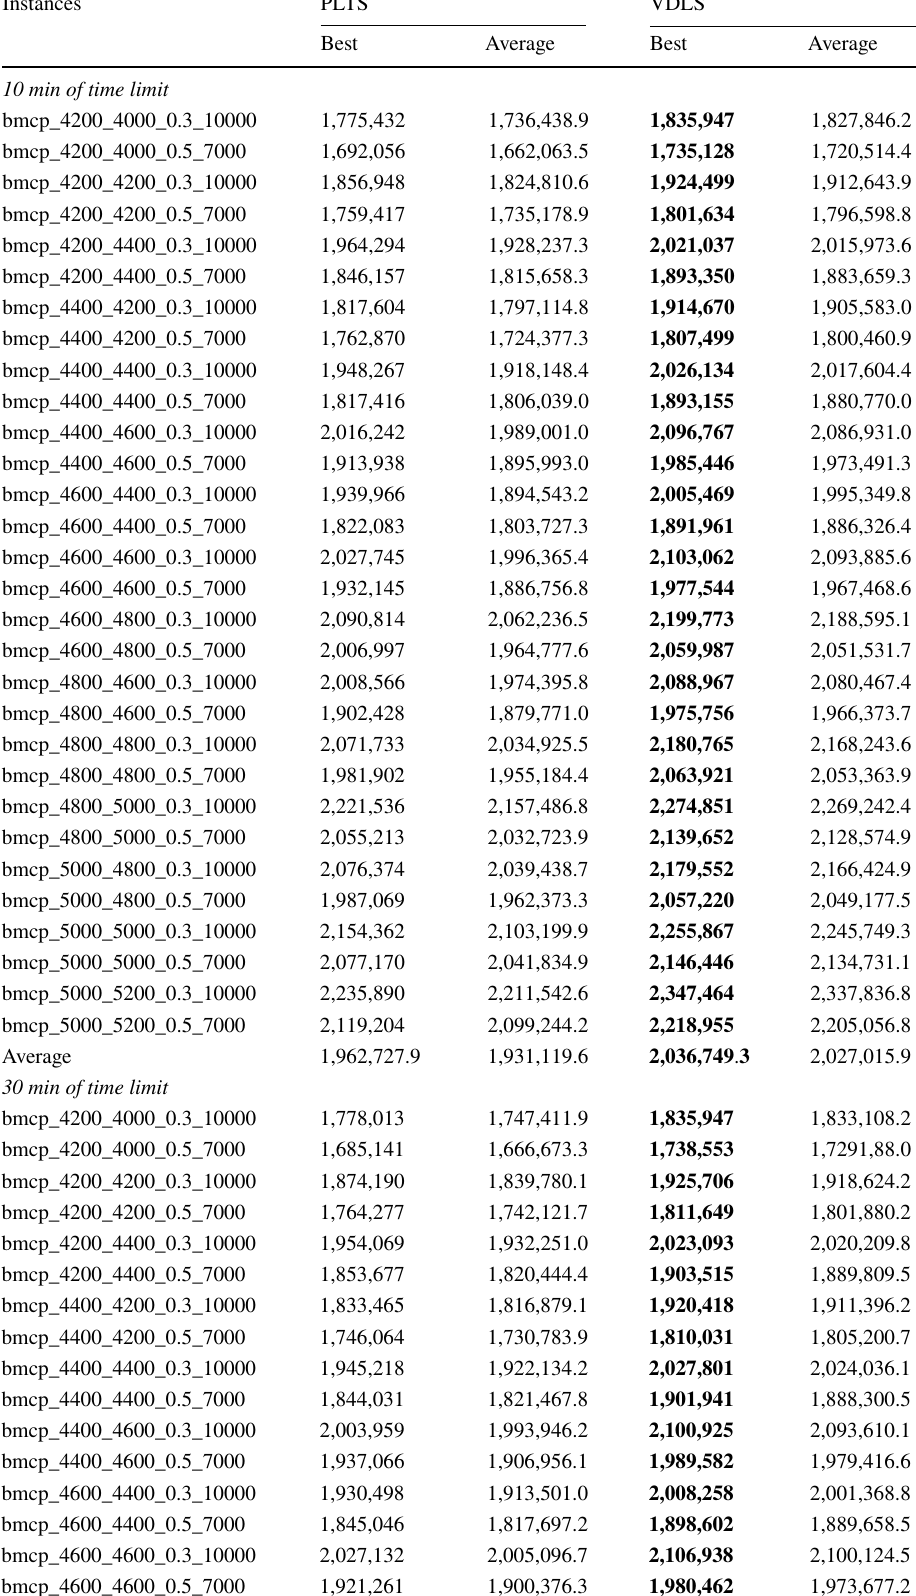
Table 5 Comparison results of VDLS and PLTS, with 10 or 30 min of time limit, on the 30 instances of the third